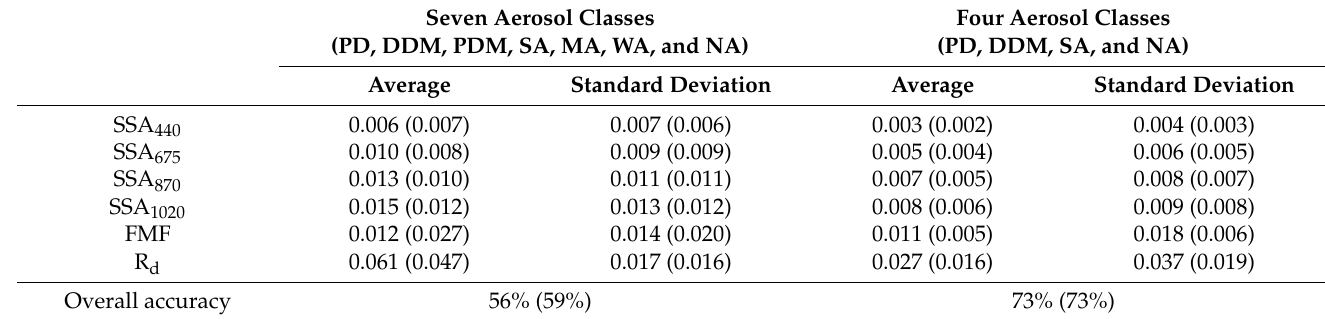
Table 5. Means and standard deviations of differences in SSAs, fine-mode fraction (FMF), and aerosol absorbance and dust ratios (R d) values for several aerosol classification models identifying seven or four aerosol types. Values in parentheses are from Choi et al.